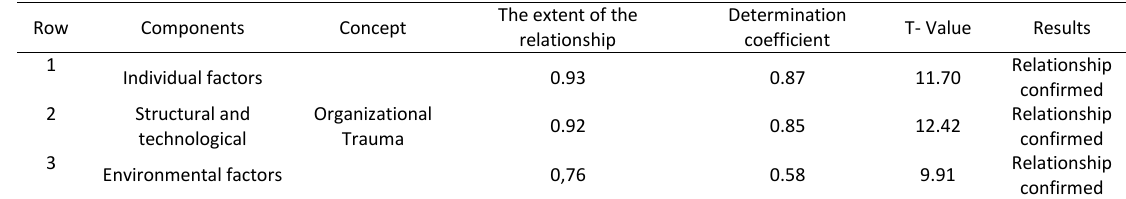
Table 7. Relationships of components with organizational trauma